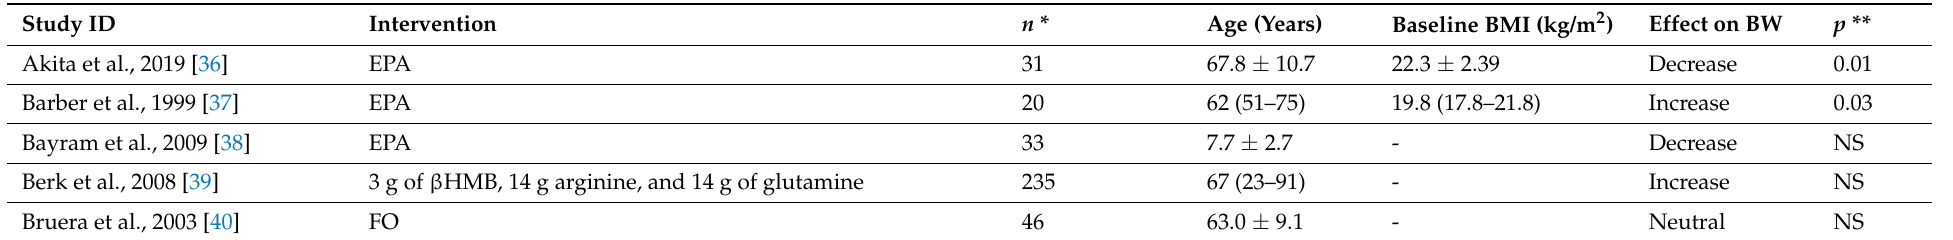
Table 2. The dynamics of patients’ body weight after nutritional intervention in the studied clinical